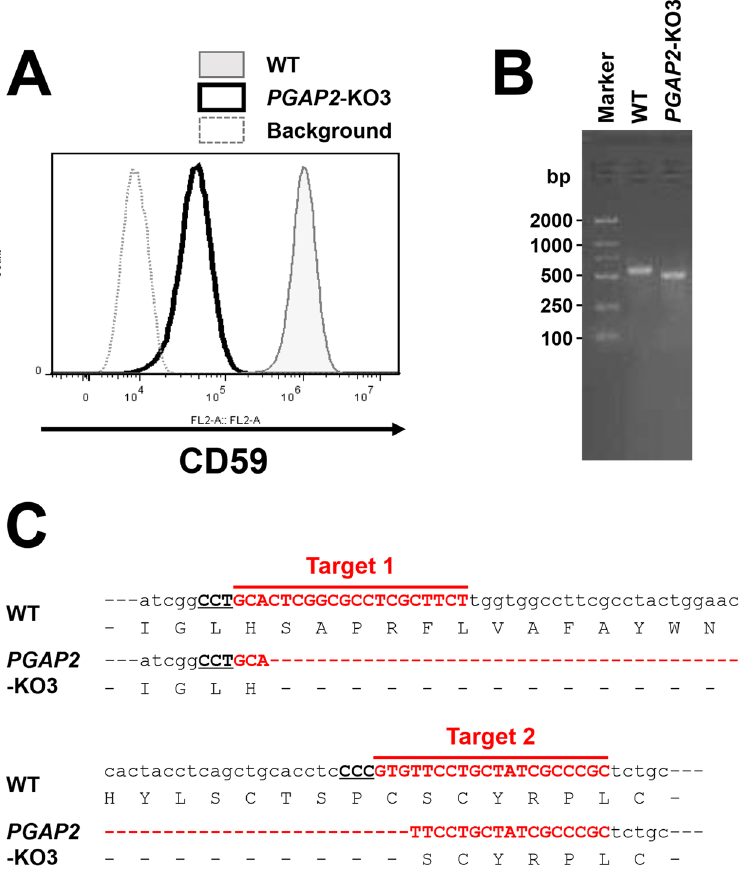
Figure 2. Generation of the PGAP2 -KO cell line. ( A ) After the PGAP2 gene was knocked out, the expression of CD59 in a clonal cell line named PGAP2 -KO3 was analysed. Compared with the wild-type HEK293 (WT), the expression level had decreased significantly in PGAP2 -KO3 cells. ( B ) Genomic DNA was extracted from wild-type HEK293 (WT) and PGAP2 -KO3 cells. The knockout region was amplified and analysed by agarose gel electrophoresis. The full image of the gel was included in the supplementary information. ( C ) Sequencing results revealed that there was a deletion of 66 nucleotides in PGAP2